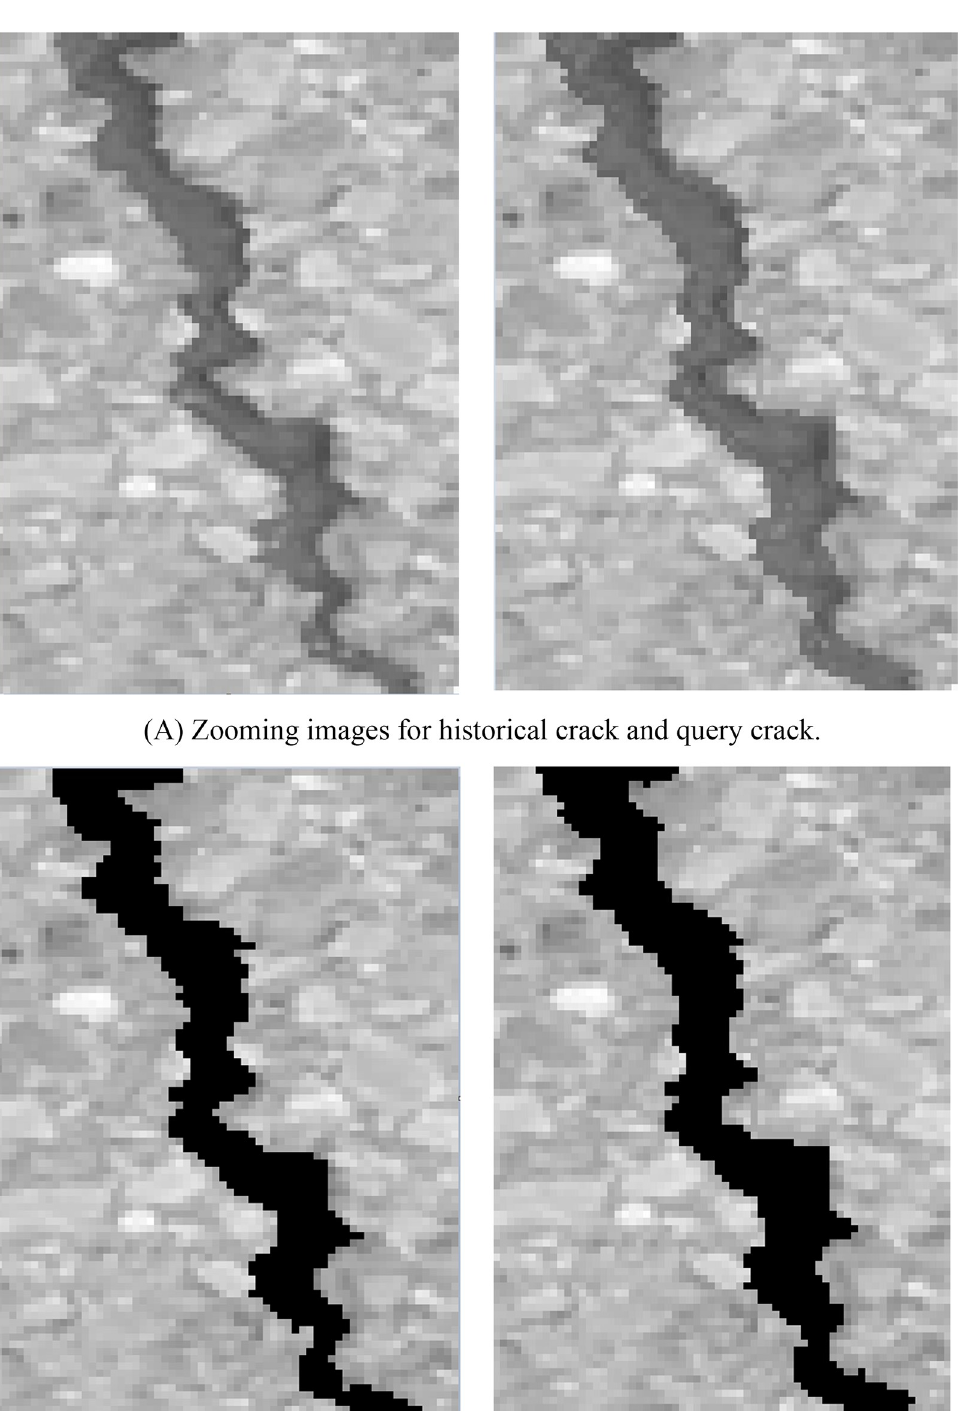
Fig 11. Crack growth detection on WUT dataset.